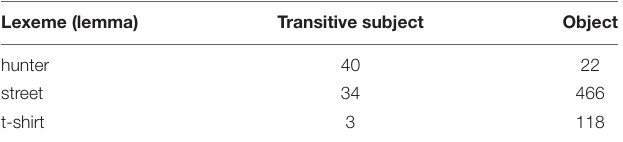
TABLE 5 | A fragment of the Lexeme – Role matrix for